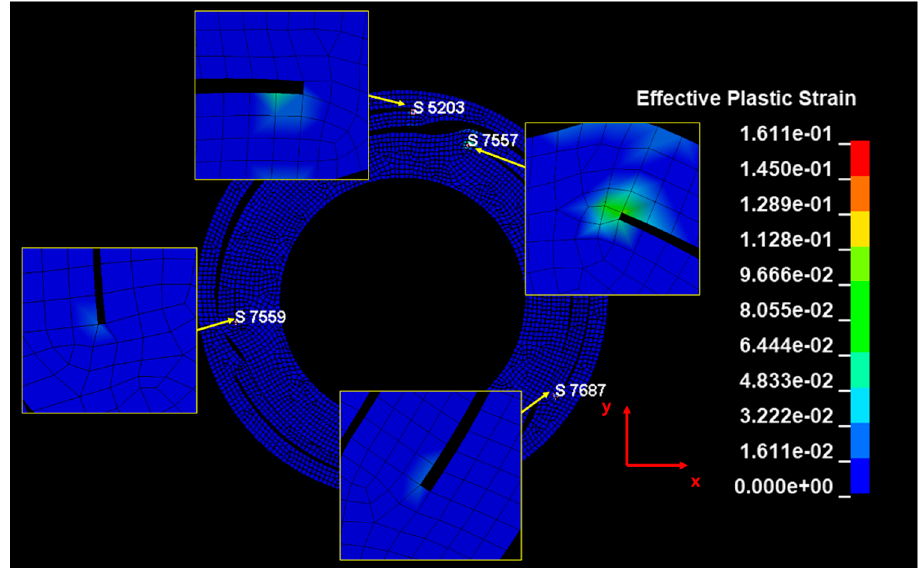
Figure 12. Effective stress of haptic spring at the moment of impact.